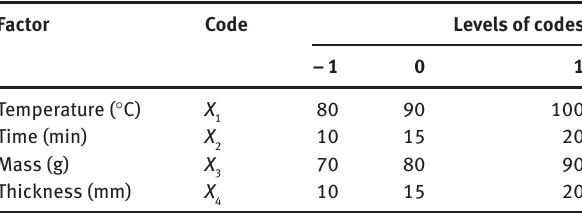
Table 2: Variables and experimental design levels for response surface.